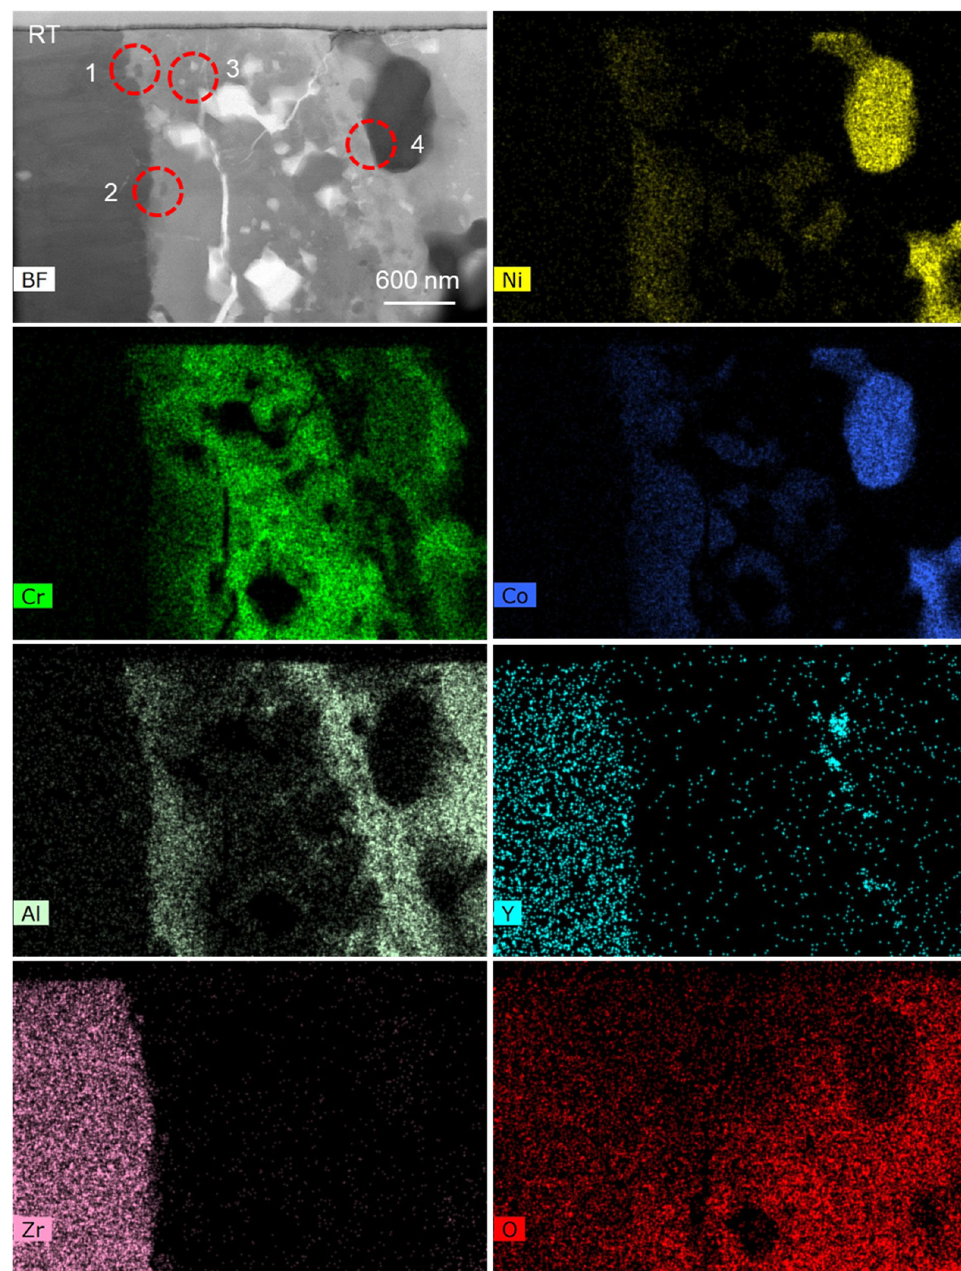
Figure 3. STEM-EDS elemental maps of the TBCs sample with magnification of 20,000.